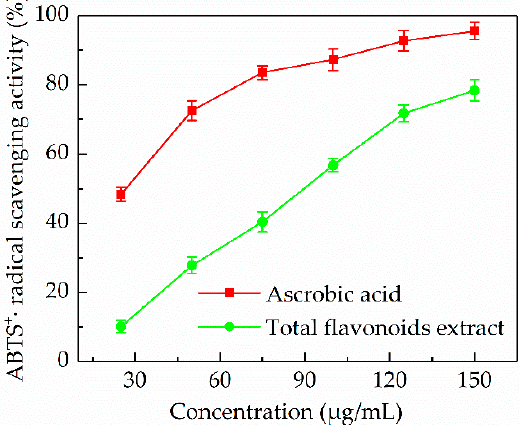
Figure 5. Scavenging activity of the P. cretica extract obtained by optimized ultrasound-assisted extraction against ABTS + • radical compared with